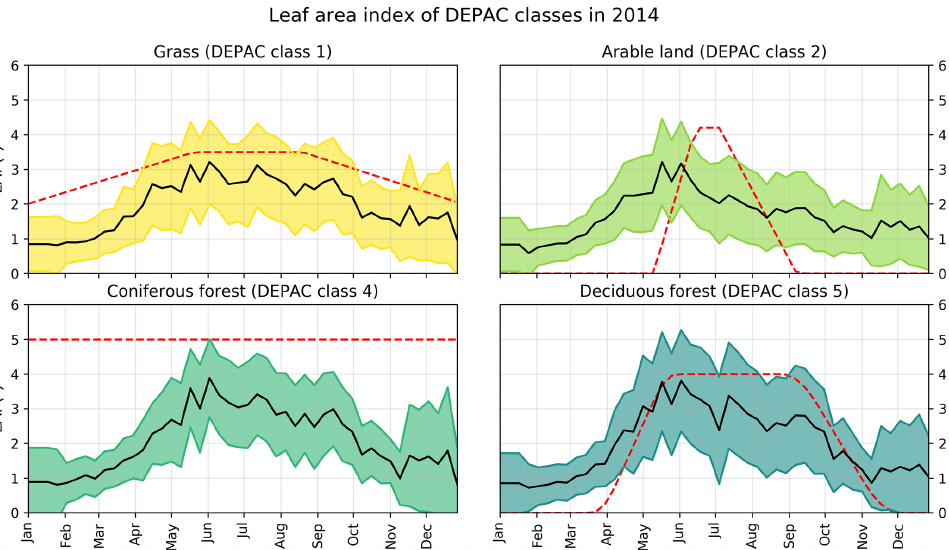
Figure 8. Seasonal variation of the default and MODIS LAI values per DEPAC class. The black line represents the mean MODIS LAI of all pixels within the modelled grid for that particular DEPAC class; the ranges represent the mean plus and minus the standard deviation of the MODIS LAI. The red line depicts the default LAI values in LOTOS-EUROS.